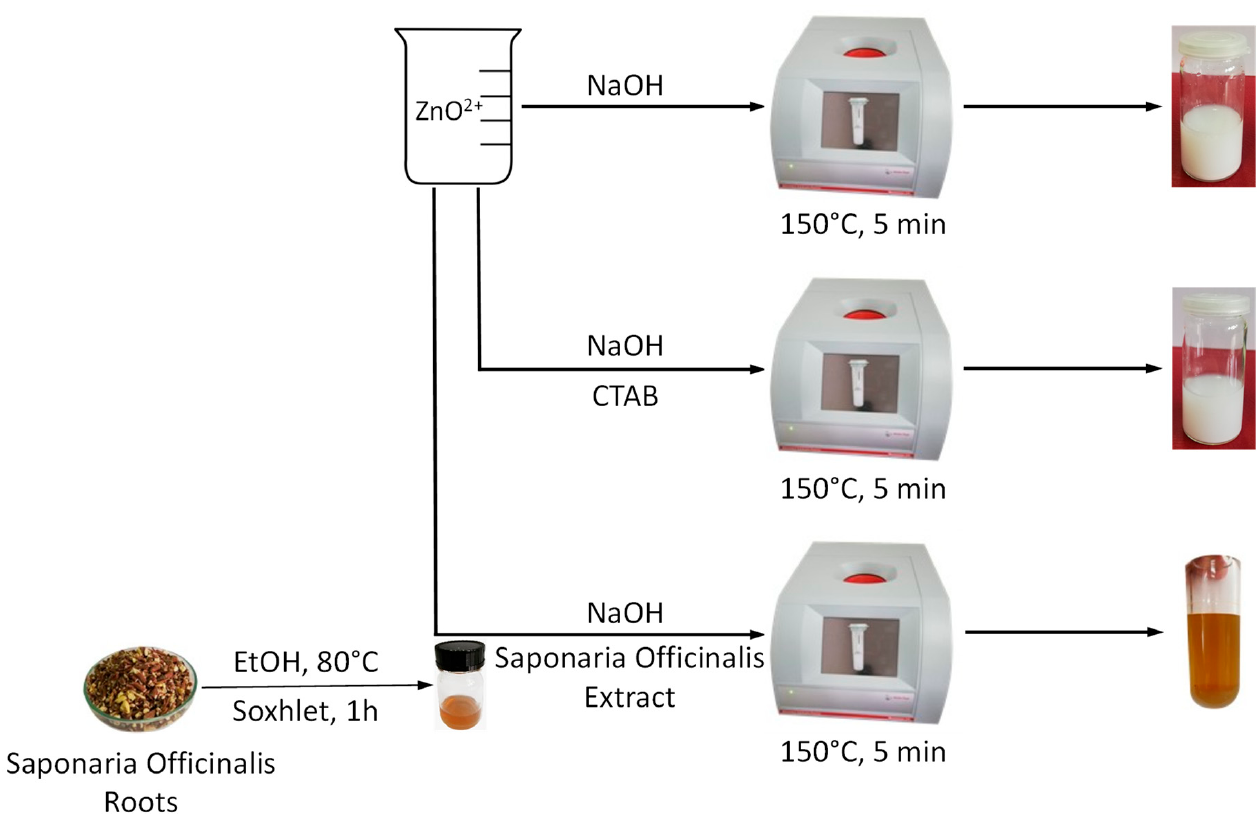
Figure 1. Schematic view of the microwave-assisted synthesis of ZnO NPs with natural and synthetic capping agents. The effect of synthetic and natural surfactants (CTABr and saponins from Saponaria officinalis extract) as capping and structuring agents on the size and shape of the obtained ZnO nanopowders was investigated. The conditions of the synthesis and sample codifica- tion are presented in Table 1. Table 1. The synthesis conditions of ZnO samples prepared in the study. Sample Code